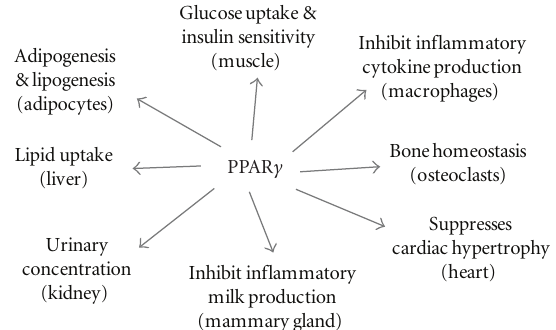
Figure 2: Pleiotropic functions of PPAR γ in di ff erent organs/tissues.